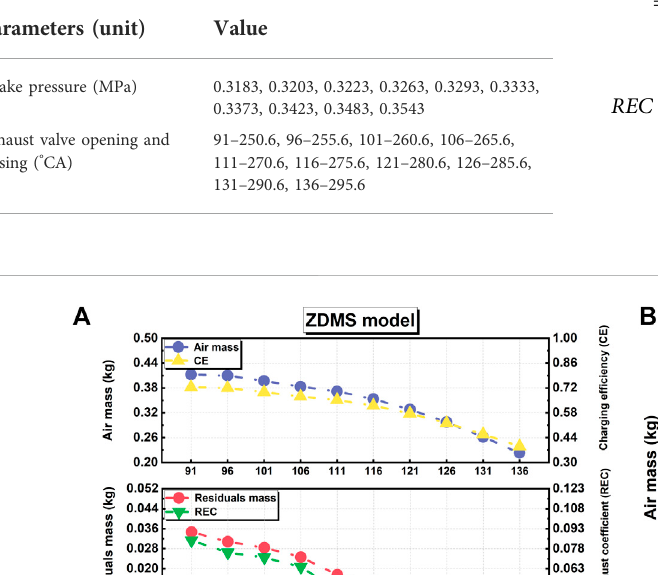
TABLE 8 Relevant input parameters under 75% load.